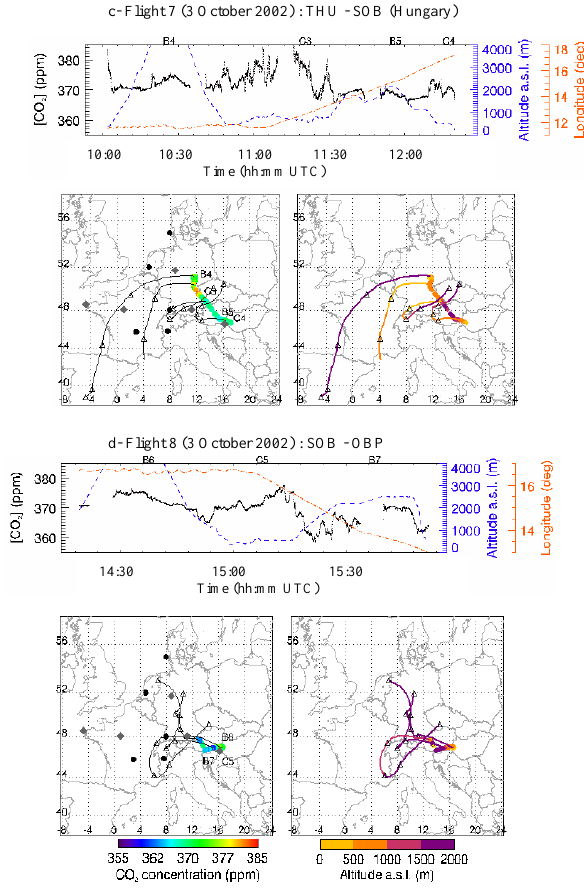
Fig. 6. (c, d) Back-trajectories computed over 96h for flights 7 and 8. The distance between 2 triangles is 24h. Left panels show CO 2 concentrations along the flight path and back-trajectories. Right panels show the altitude of the flight, and back-trajectories colored according to air mass altitude. Black circles represent ground sta- tions named in Fig. 1. Altitude is given in meters above the sea level (m a.s.l.). Note that some of the back-trajectories are outside the latitude and longitude chosen borders, but these are so diluted that they do not give any relevant information.